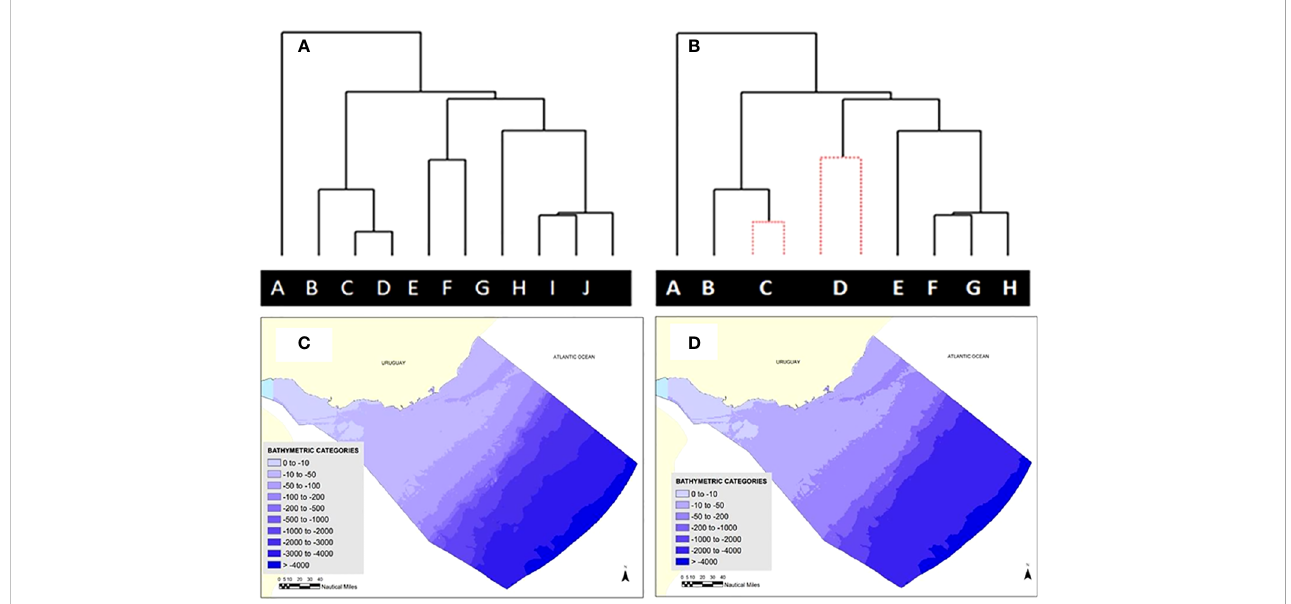
FIGURE 1 (A) Original cluster (Group Average Link) using the Bray-Curtis Similarity Index, of categories of environmental variables according to the multivariate community structure based on Primary Biodiversity Records (PBRs); (B) SIMPROF routine highlights no remaining structure for some pairs of the original categories (no signi fi cant difference in community structure). New categories are constructed merging two or more original categories (C) Maps of the distribution of original depth categories and (D) recategorized according to their effects in community structure. This procedure was applied also for Salinity and Water Masses categories. Each of the uppercase letters in Figure 1 represents a bathymetric